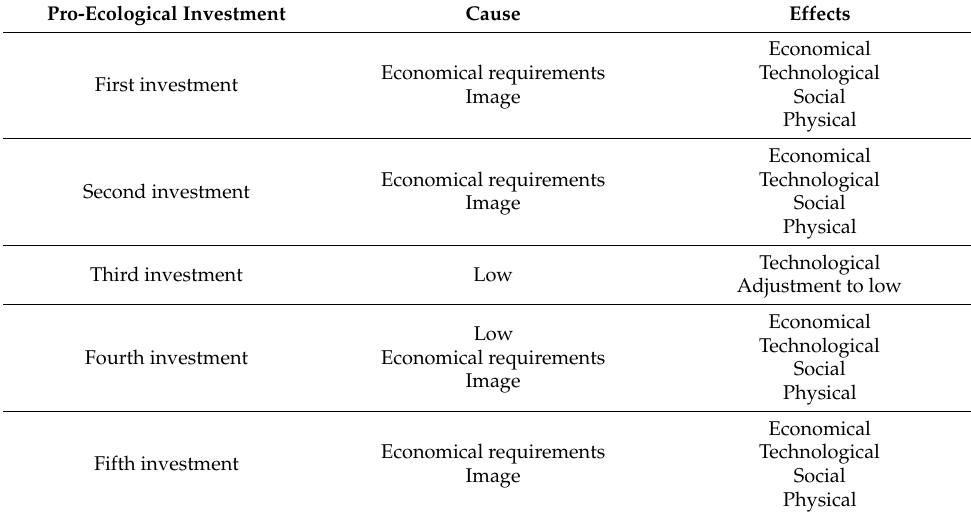
Table 3. Implemented technologies from cause–effect model point of